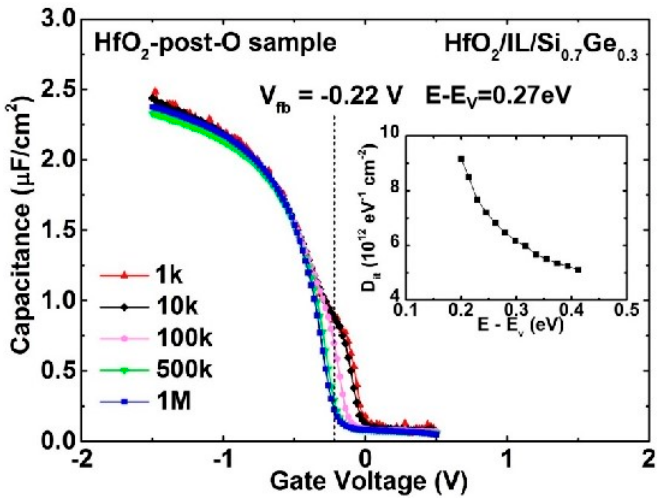
Figure 2. Multi ‐ frequency C ‐ V characteristics of HfO 2 ‐ post ‐ O sample with 30 min oxidation time (indirect). The corresponding energy distributions of D it is given in the inset.